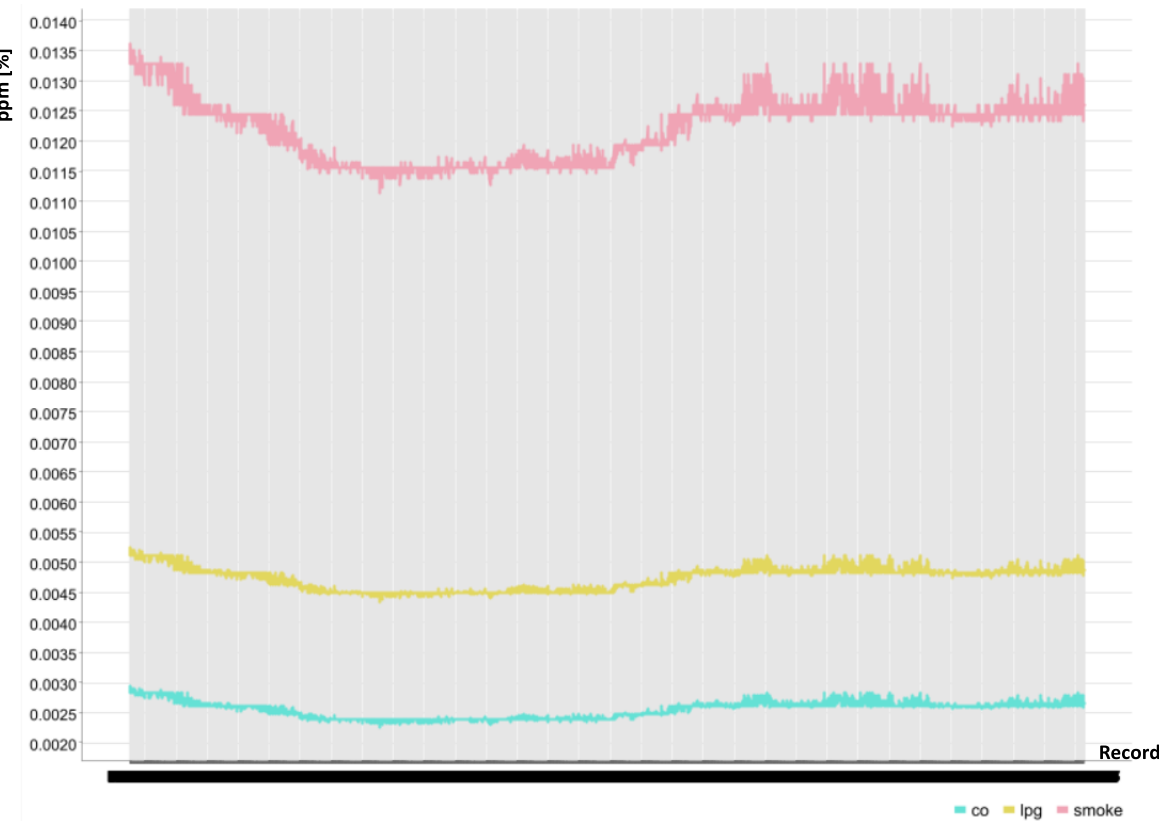
Figure A2. First 4,000 records of the most important variables chosen for the data processing ( co , lpg , and smoke variables).